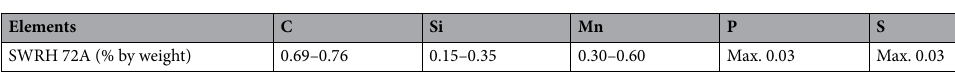
Table 1. Nominal chemical composition of the shot balls 23 .